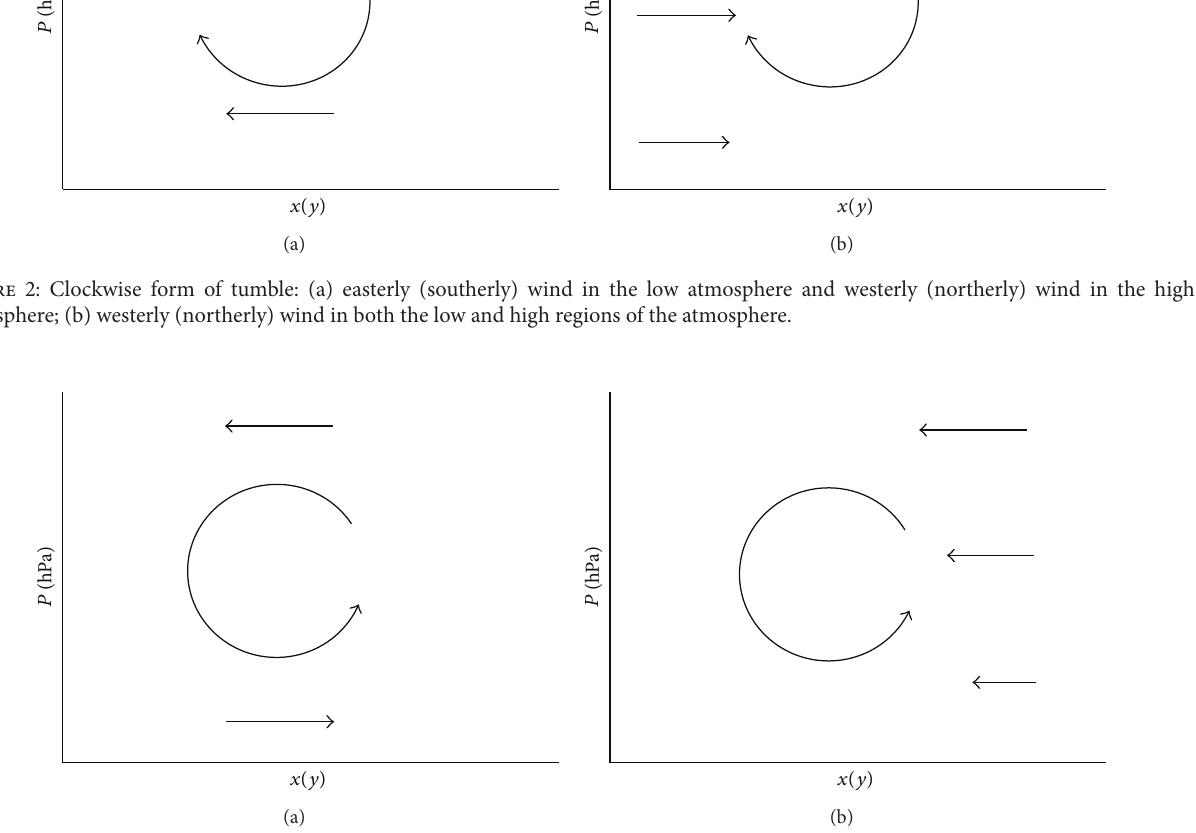
Figure 3: Counterclockwise form of tumble: (a) easterly (southerly) wind in the high atmosphere and westerly (northerly) wind in the low atmosphere; (b) easterly (southerly) wind in both the low and high regions of the